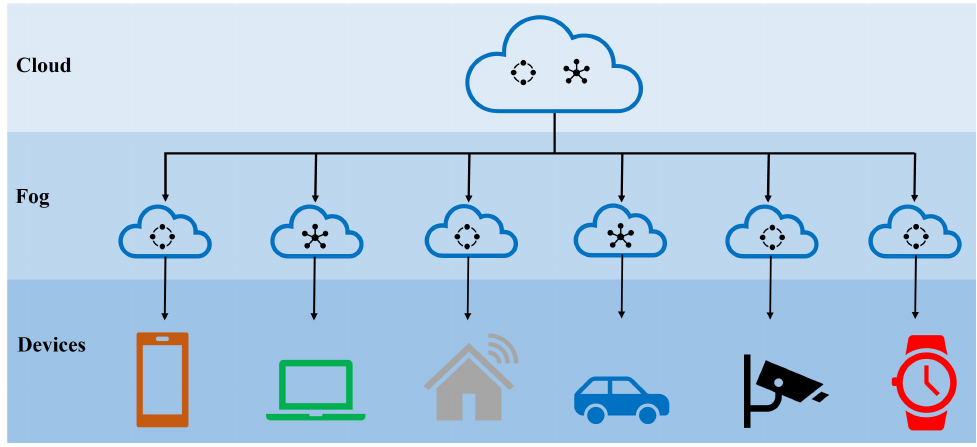
Figure 9. IoT data processing in cloud and